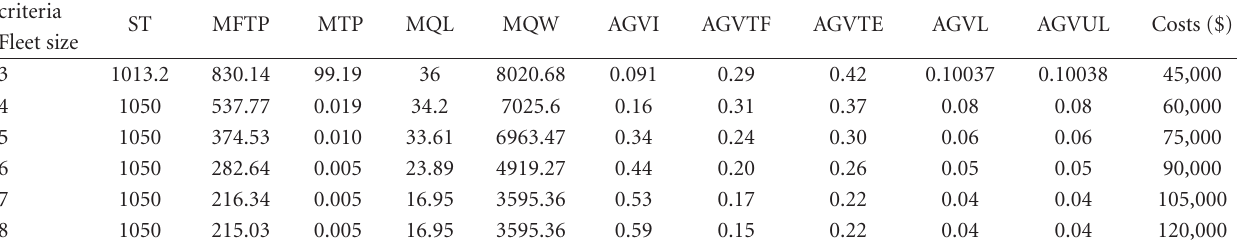
Table 10: Simulation results for di ff erent fleet size.